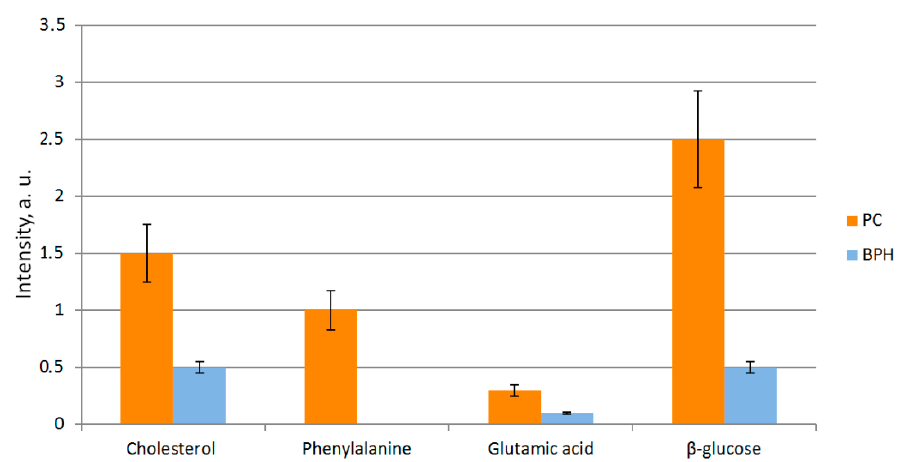
Figure 3. Relative intensities of Raman shifts, with error bars denoting several substances identified in PC and BPH samples. Level «0» corresponds to the level of noise in the spectrometer, which does not allow detecting signals that are lower in intensity than these